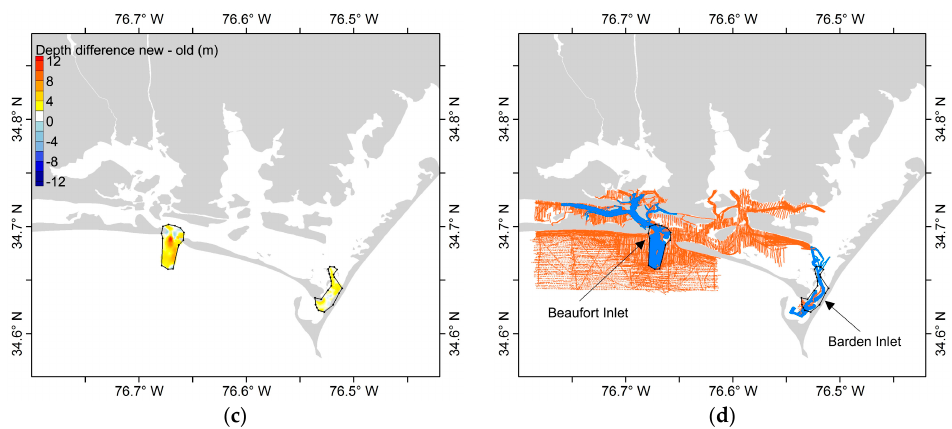
Figure 3. The morphological changes around Beaufort Inlet and Barden Inlet: ( a ) the old-bathy grid depths; ( b ) the new-bathy grid depths; ( c ) the depth difference between the new-bathy grid and the old-bathy grid; ( d ) the original bathymetry sounding data points (orange: data in 1953 around Beaufort Inlet and data in 1955 around Barden Inlet; blue: data in 2010 around Beaufort Inlet and data in 2015 around Barden Inlet). The black dotted polygons delineate the area with changed bathymetry.